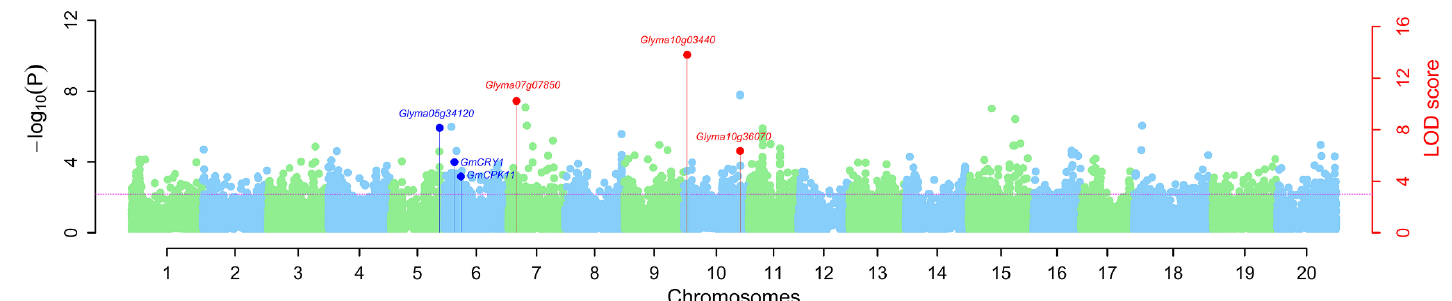
Figure 4. The expressional levels [log 2 (RPKM + 1)] of potential candidate genes associated with seed weight in seven soybean tissues. Among the nine genes, three were previously reported seed-weight genes (bold text) in soybean, three were lowly expressed genes (grey text), and three were newly identified as candidate genes (red text) to be related to seed size / weight and development.